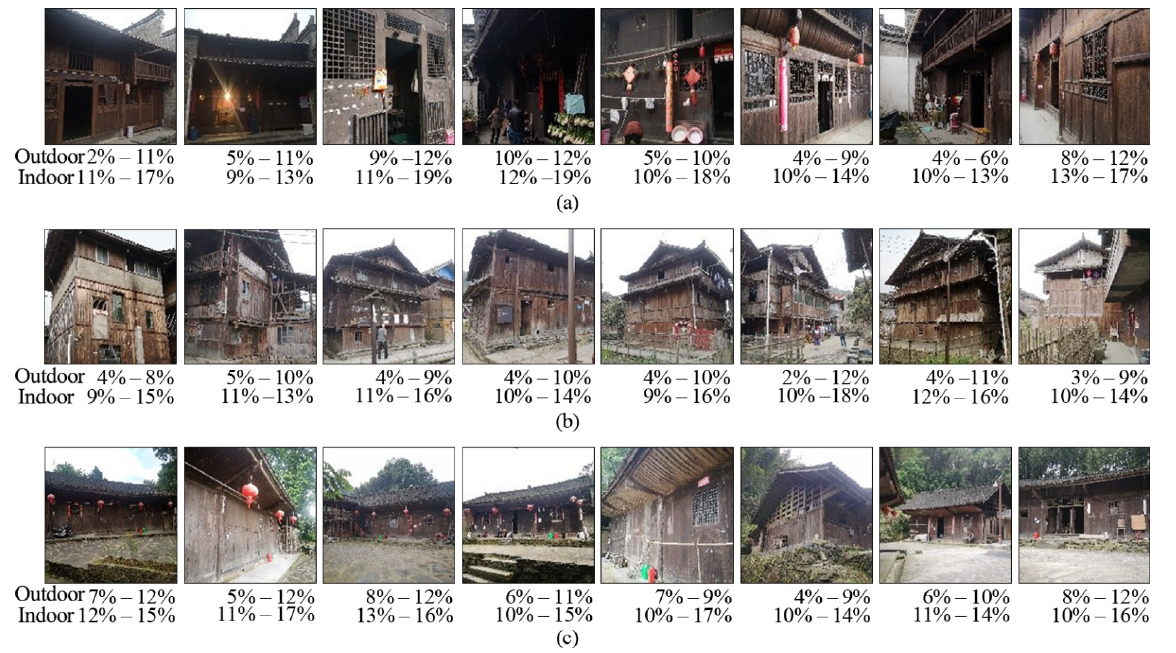
Figure A1. The results of a survey of street dimensions in ( a ) Laohaoyingpan Village; and ( b ) High chair Village.